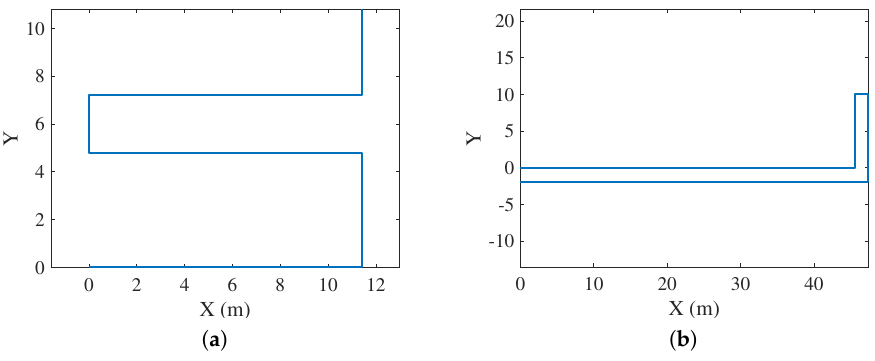
Figure 4. Walking trajectories. ( a ) Trajectory A. ( b ) Trajectory